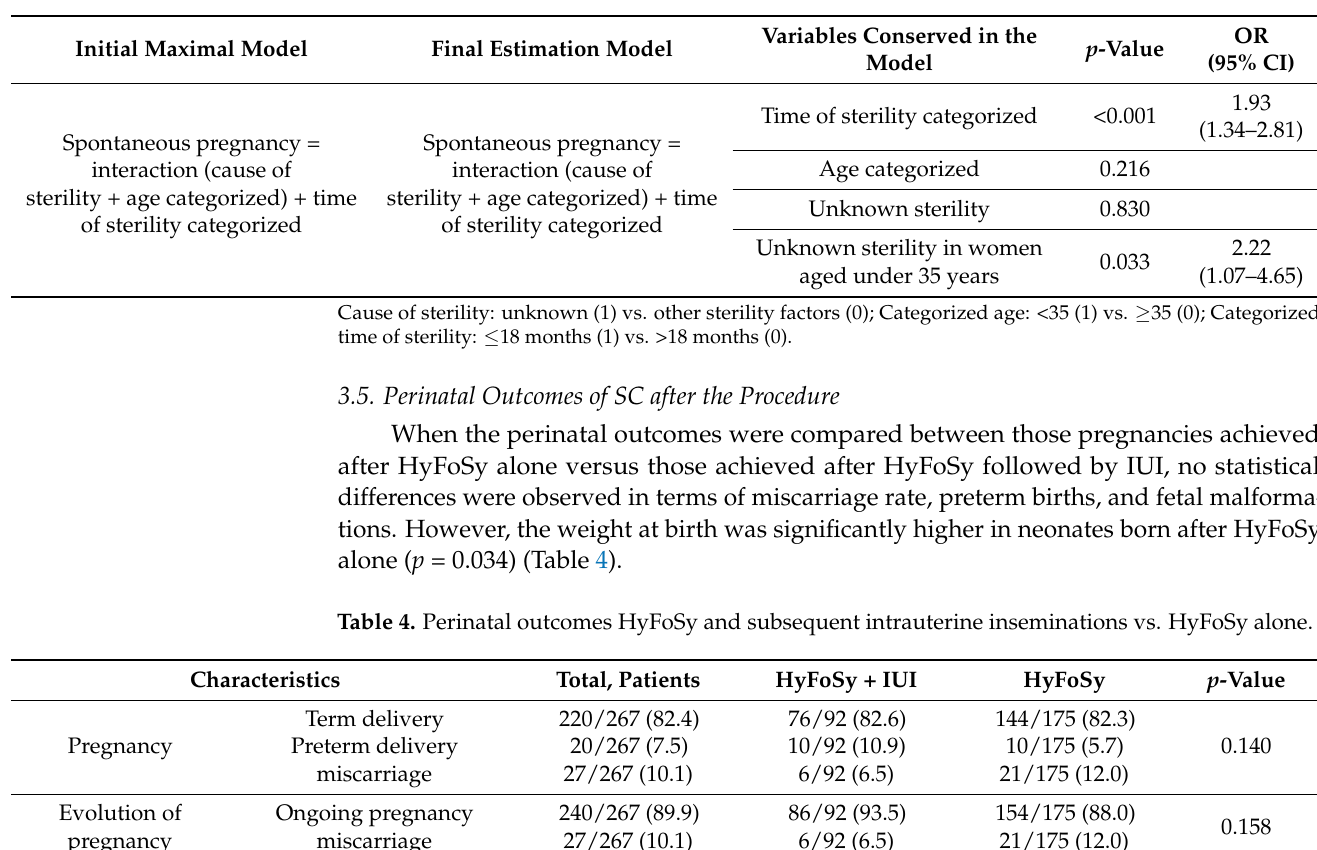
Table 3. Multivariable analysis of the risk of spontaneous pregnancy after HyFoSy examination.